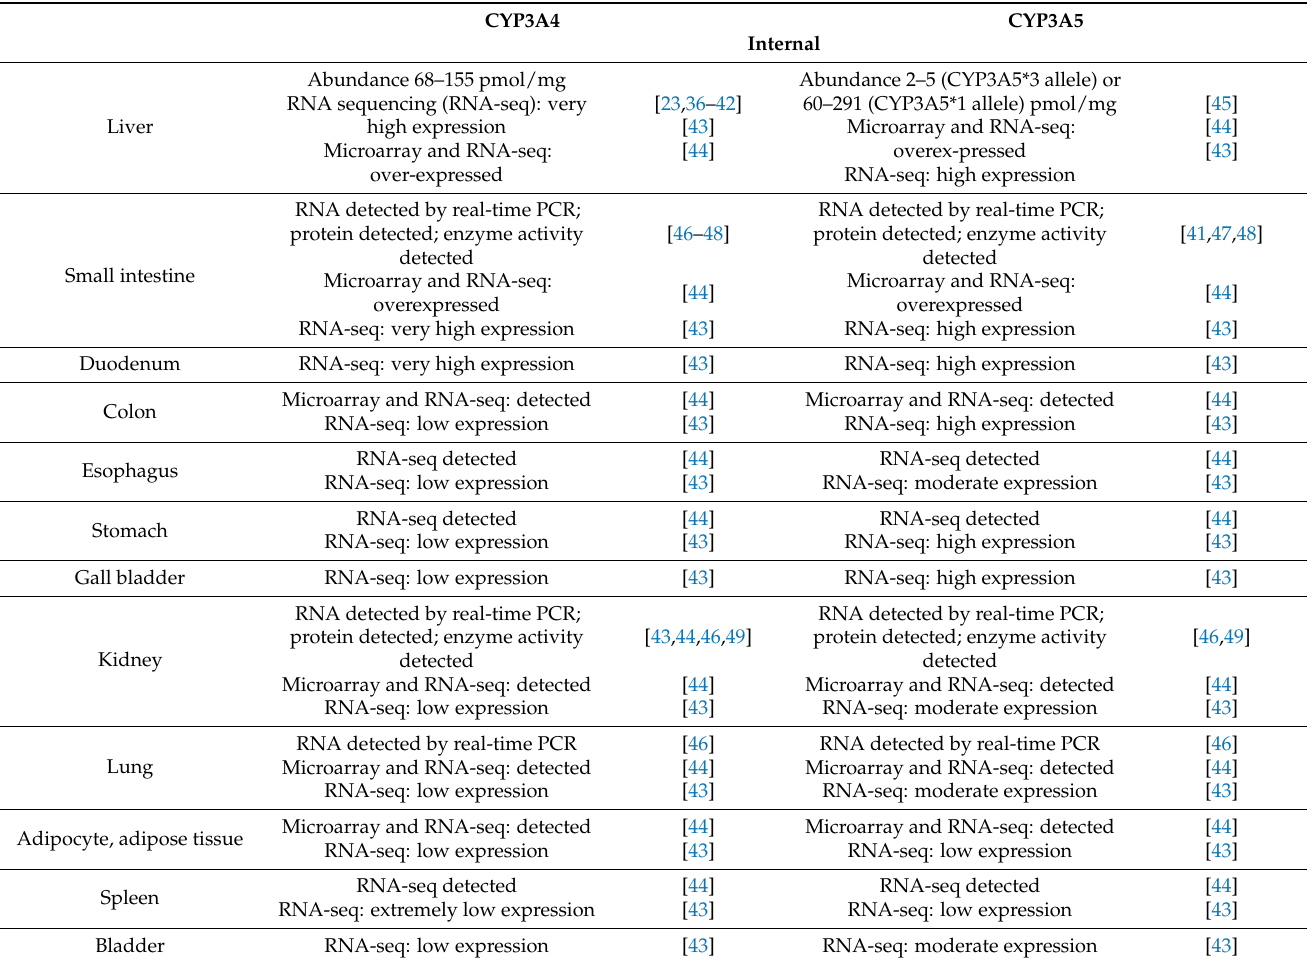
Table 1. Hepatic and extrahepatic expression profiles of human CYP3A4 and CYP3A5. CYP3A4 CYP3A5